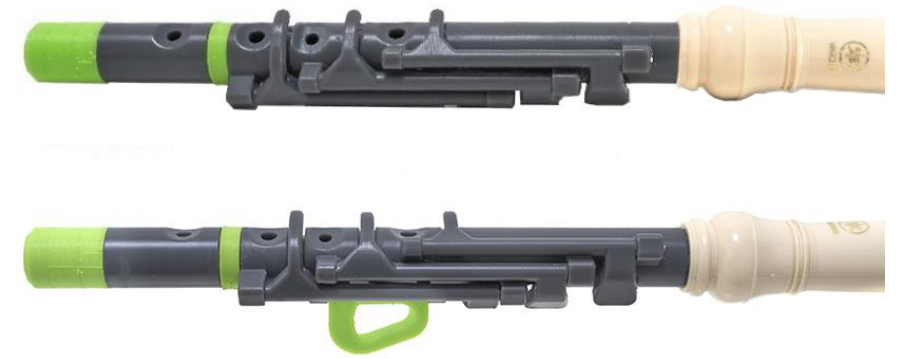
Figure 5. Final design of prototype 2 of Flow.